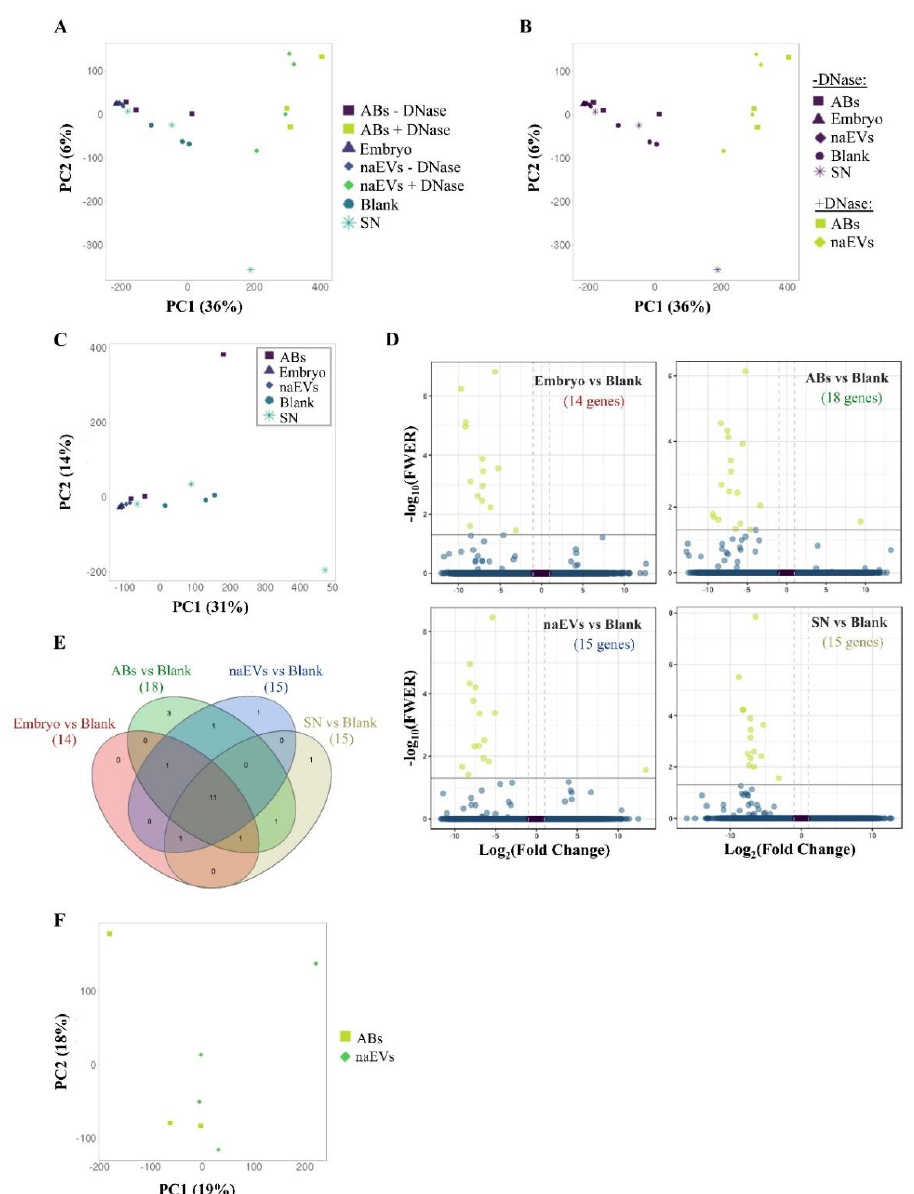
Figure 4. Analysis of the DNA produced and released by the murine embryo to the culture media. ( A ) PCA showing similarity between samples using normalized counts of 27,207 genomic features of the DNase treated and untreated EVs fractions produced by the embryo, the culture media as a negative control (blank), the embryo itself as a positive control, and the SN as an EVs free fraction. ( B ) PCA showing sample distribution by treatment showing separated clusters by treatment. ( C ) PCA of separate analysis using DNase untreated samples, including embryo, Abs, naEVs, SN, and blank control (normalized counts of 26,997 genomic features). PCA shows the similarity between fractions and replicates. ( D ) Volcano plots showing di ff erential enriched genes in the studied fractions (embryo, ABs, naEVs, or SN) compared to the blank control. Negative FC values (left) indicate genes that are enriched in each fraction with respect to the blank medium, while positive values (right) correspond to genes enriched in the blank medium compared to the studied sample. The number of di ff erentially enriched genes is shown in brackets for each comparison. ( E ) Venn diagram showing common and specific enriched genes in pairwise comparisons. ( F ) PCA of DNase treated replicates showed no di ff erences between DNA content in the treated vesicle subpopulations. Abbreviations: AB, apoptotic bodies; naEVs, smaller in size extracellular vesicles (including microvesicles and exosomes); SN,